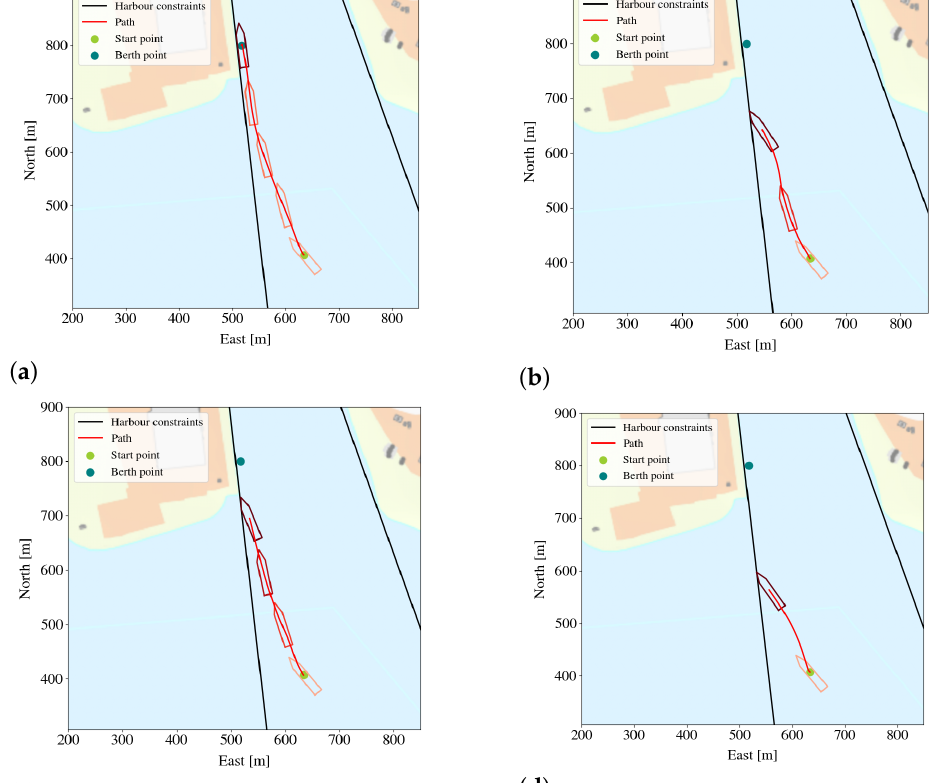
Figure 8. ( a ) Successful run by the PPO-policy, ( b ) failed run by the LMT OFS 100, ( c ) failed run by the LMT OFS 312 , and ( d ) failed run by the LMT